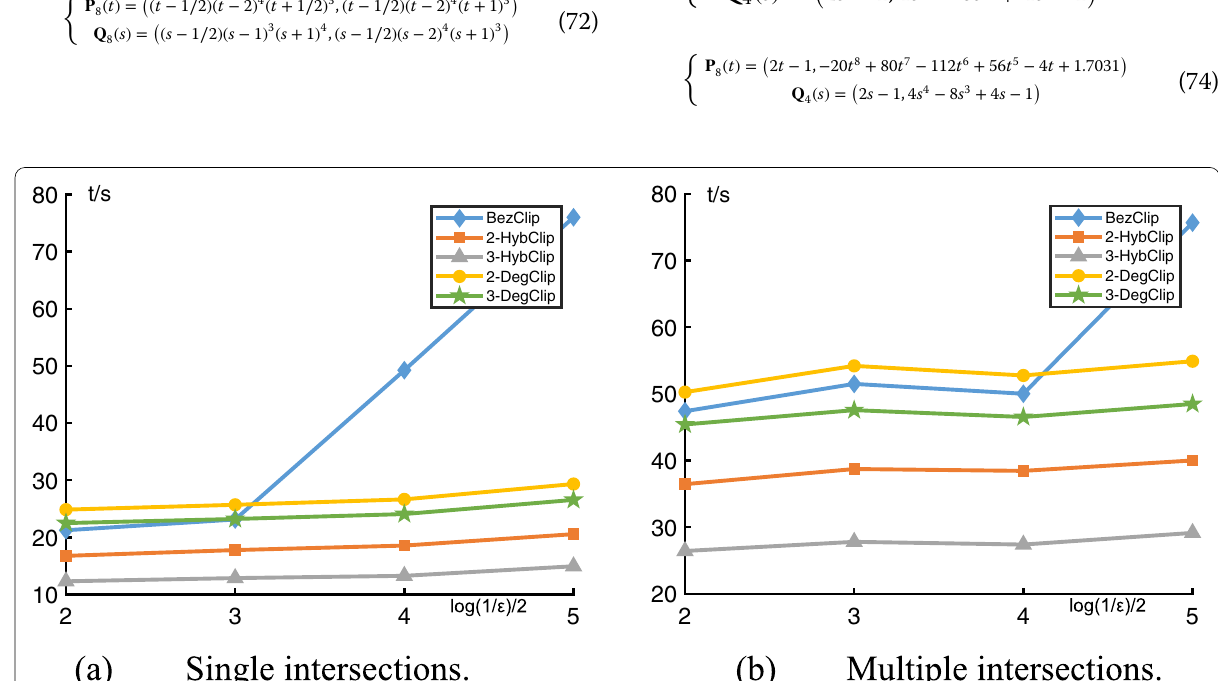
The five algorithms are applied to three pairs of Bézier curves with tangent intersections. Table 2 and Fig. 7b report the number of pairs of iterations and the computing time in milliseconds of various desired accuracies ε for computing the tangent intersections between the three curve pairs with various degrees. Experimental results show that the quadratic and cubic clipping techniques are better than Bézier clipping; however, compared with quadratic clipping based on hybrid curves or a degree reduction, the cubic clipping techniques show no substantial improvements. This is due to the fact that all clipping algorithms require a large number of binary subdivisions for tangent intersections.